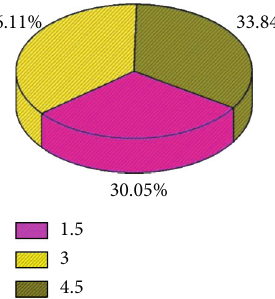
Figure 9: The contribution of silica fi ller in terms of weight percentages to